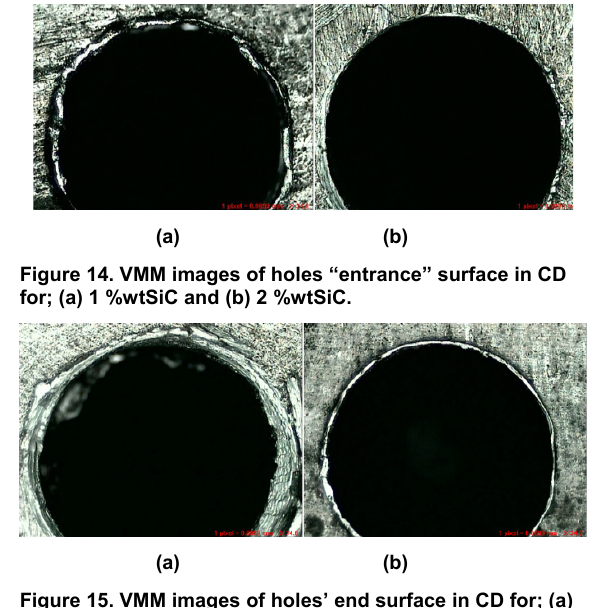
Figure 15. VMM images of holes’ end surface in CD for; (a) 1 %wtSiC and (b) 2 %wtSiC.